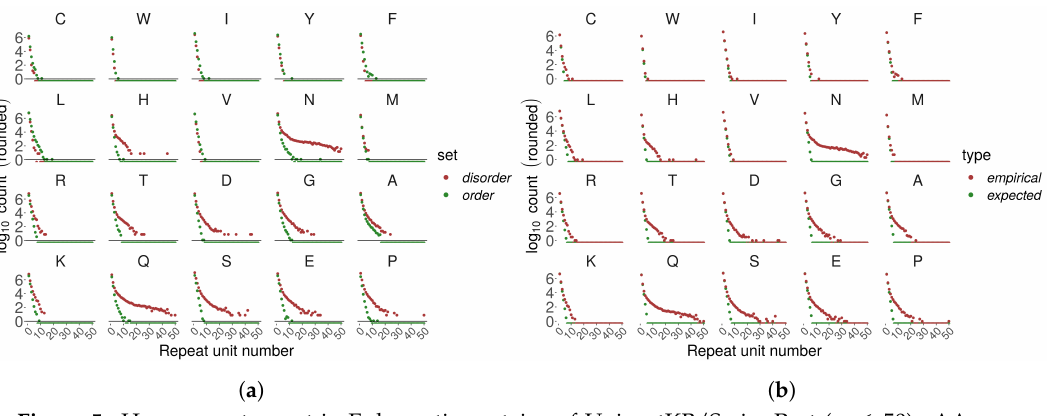
Figure 5. Homorepeat count in Eukaryotic proteins of UniprotKB/Swiss-Prot ( n ≤ 50). AAs are ordered by increasing disorder propensity (top-left to bottom-right). ( a ) Empirical count compared for regions annotated as disordered vs. ordered (consensus MobiDB annotations, no minimum length cut-off). ( b ) Total empirical count compared to expected.